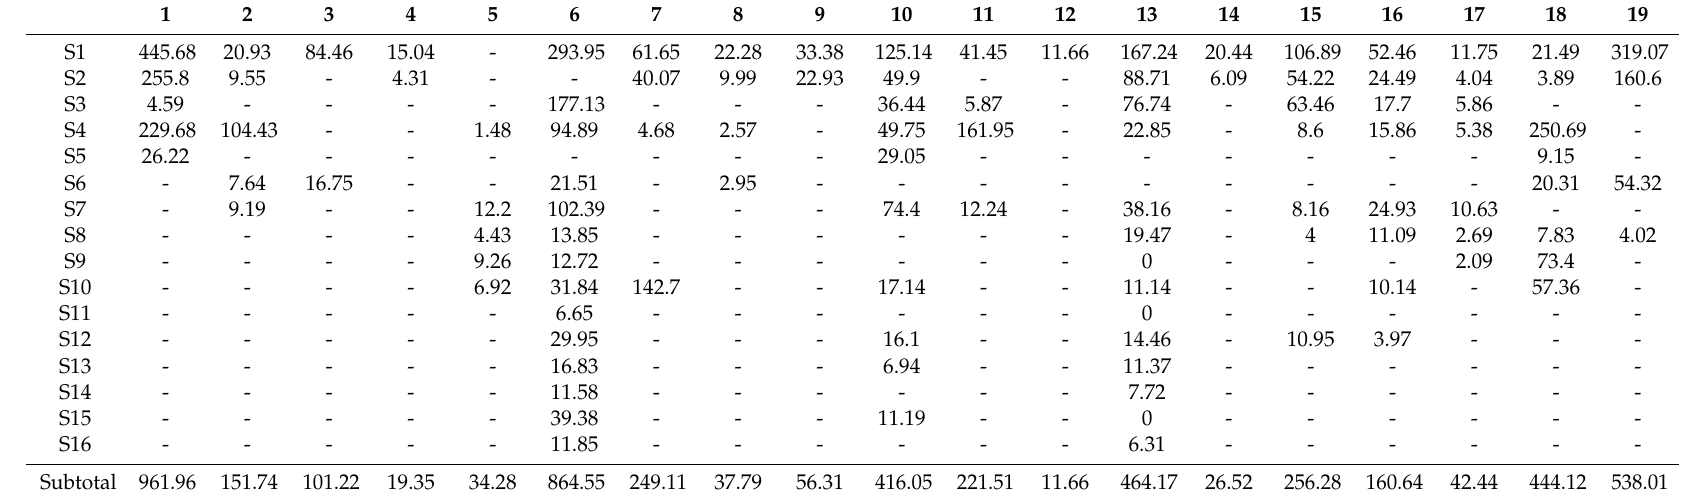
Table 3. Concentrations ( µ g/kg fresh weight (FW) equivalent of nonyl acetate) of volatile sesquiterpenes in 37 mango